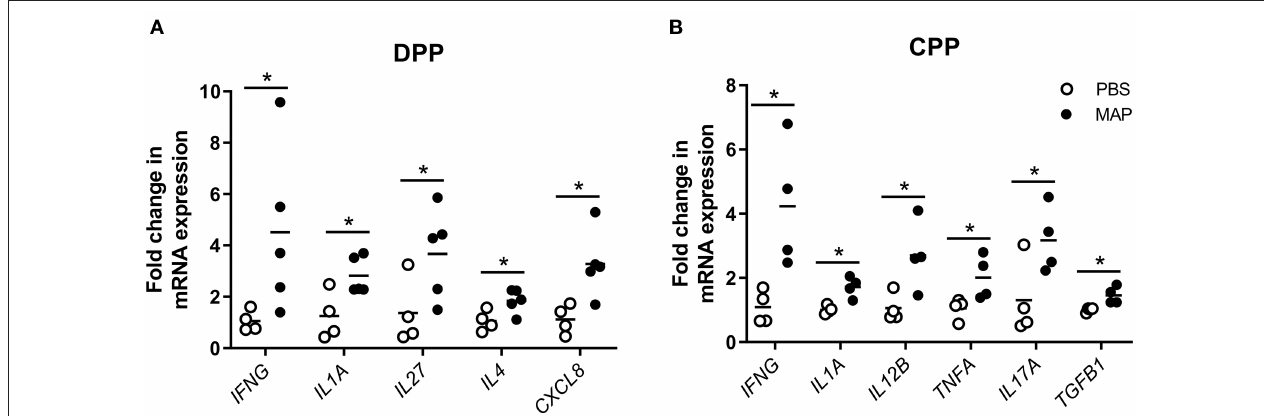
FIGURE 6 | Differentially expressed cytokine genes in MAP-infected DPP and CPP at 12 months post-infection relative to PPs collected from PBS control segments. Transcript abundance for 23 cytokine genes (assessed using the primers described in Supplementary Table 1 ) was quantified by qRT-PCR in PP tissue from (A) MAP-infected ( n = 5) and PBS control ( n = 4) DPP segments, and (B) MAP-infected ( n = 4) and PBS control ( n = 4) CPP segments. Each data point represents the fold change for each individual animal relative to the mean of the PBS control segments. Data is presented only for cytokines showing differential (* p < 0.05) gene expression in MAP-infected segments compared to PBS control segments.